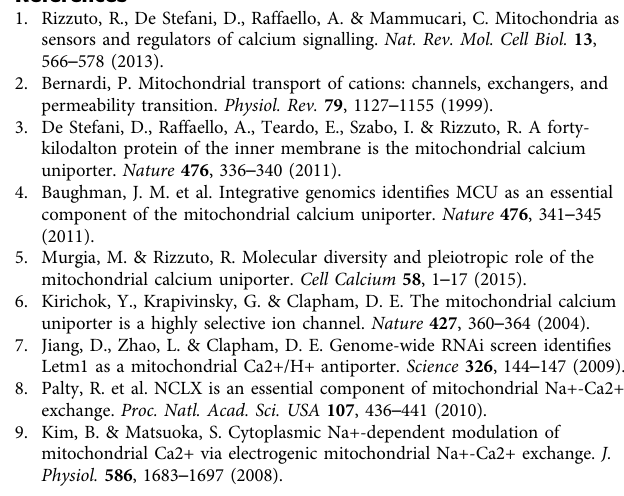
concentration is either 1.5 or 15 μ M (as described in the main text, and shown in Fig. 3g, h). [Na + ] mito is taken to be 4.54mM and [Na + ] cyt )as 10 mM. We do not model changes in sodium concentrations as these levels are far above those for [Ca 2+ ] mito_total and are assumed to be roughly constant. Mitochondrial membrane potential was set to − 20 mV, and temperature to 298 K. The initial condition for [Ca 2+ ] mito_total was set to steady state before beginning the simulation. The code to run the simulations shown in Fig. 3 is available as MatLab scripts upon